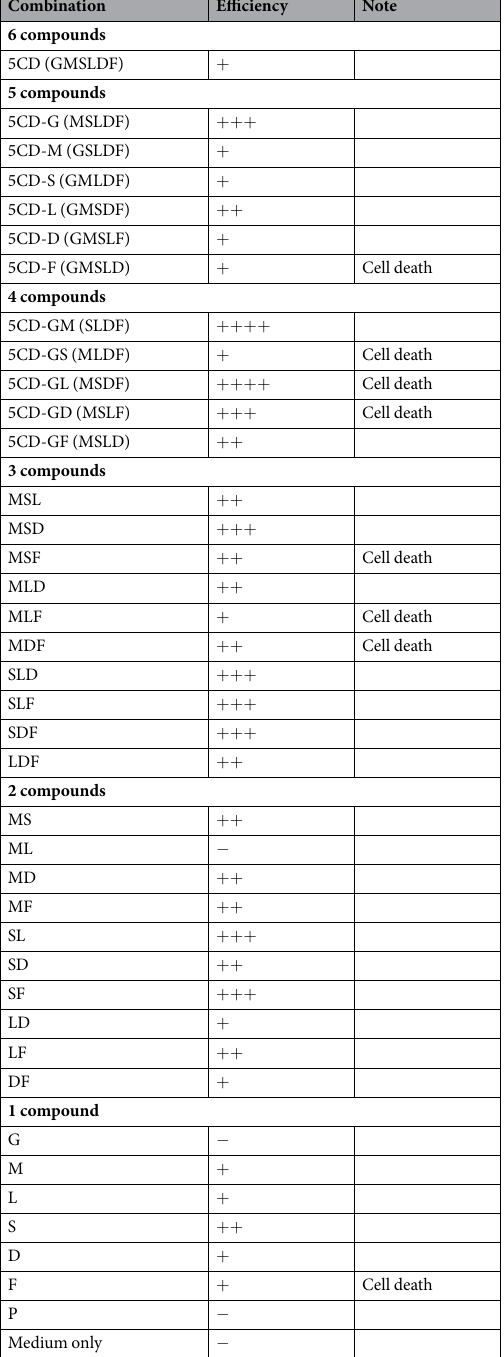
Table 2. Efficiency of direct conversion into brown adipocyte-like cells by each chemical cocktail. Rosiglitazone was included in the adipocyte medium. HDF38 fibroblasts were utilized to evaluate the